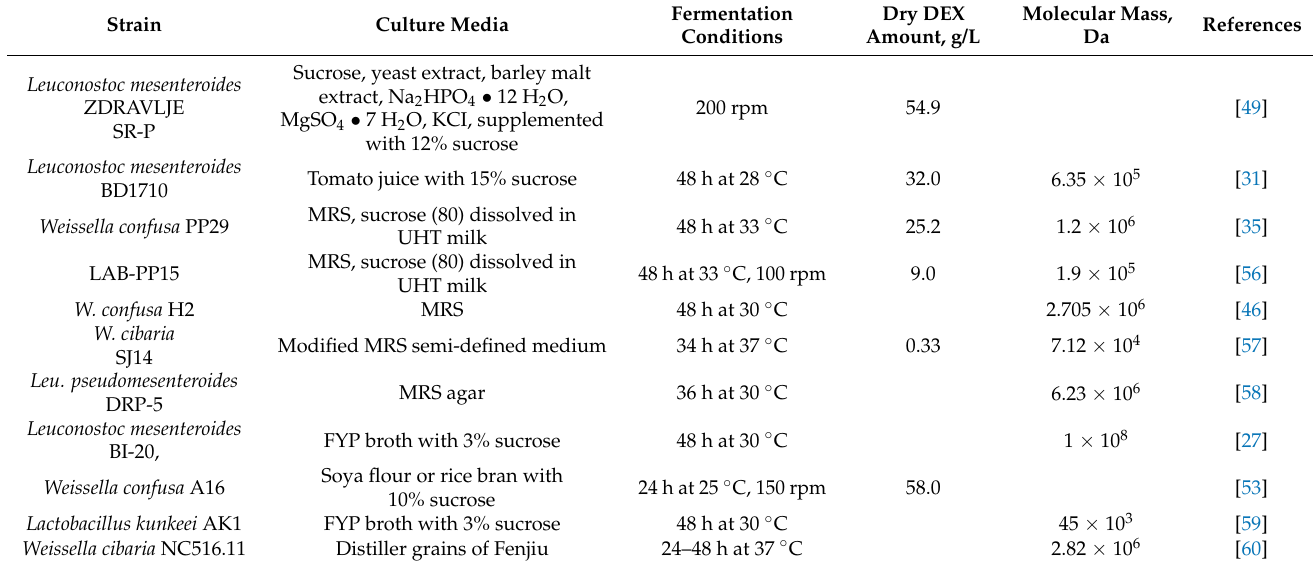
Table 1. Biosynthesized DEX amount and molecular mass depending on culture media